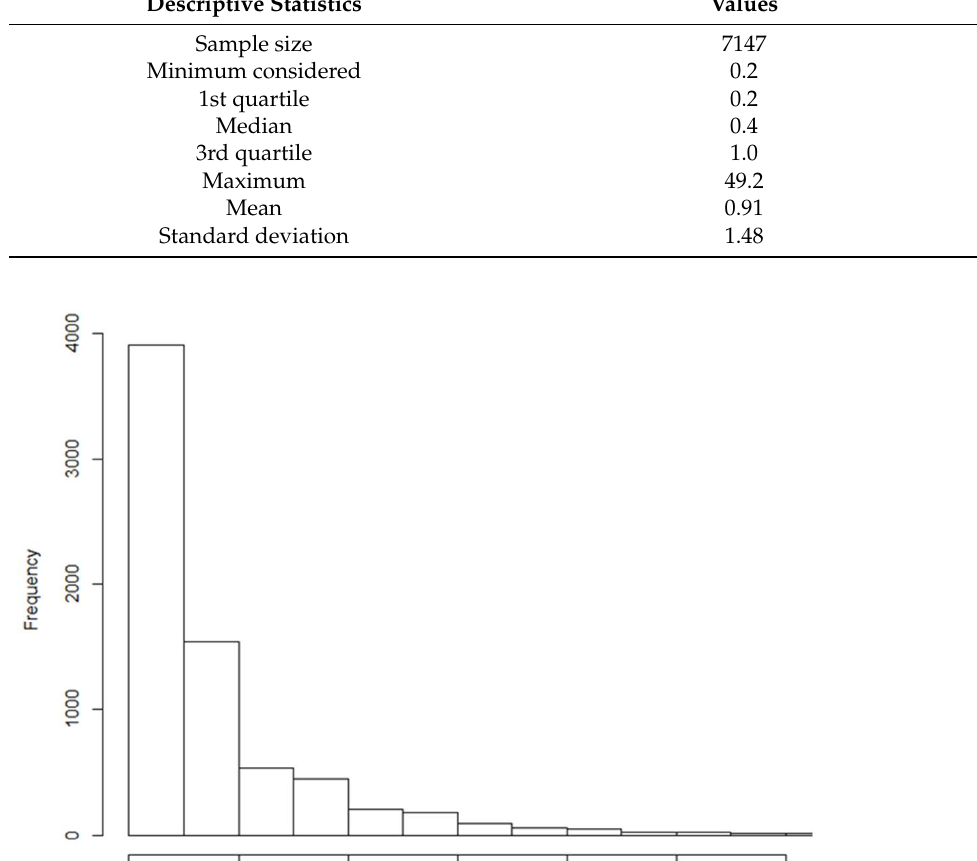
Table 2. Descriptive statistics of the PM concentrations in the three locations between 2013 and 2019.